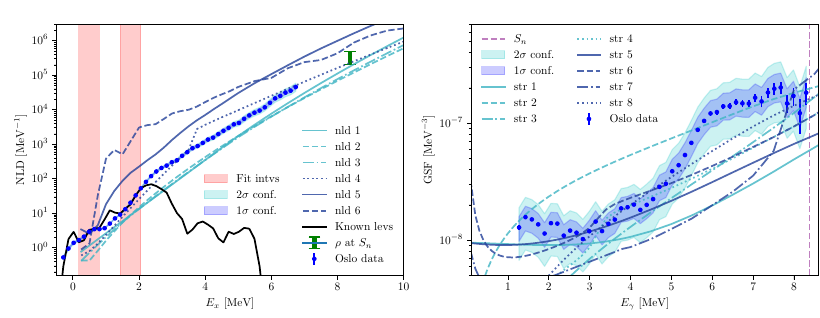
Figure 1. The NLD (left) and the GSF (right) for 127 Sb. nld and str indicate the model number obtained from TALYS 1.95 [15, 16]. The red bars in the left plot indicate the low excitation energy regions the NLD was normalized to (see Ref. [13] for